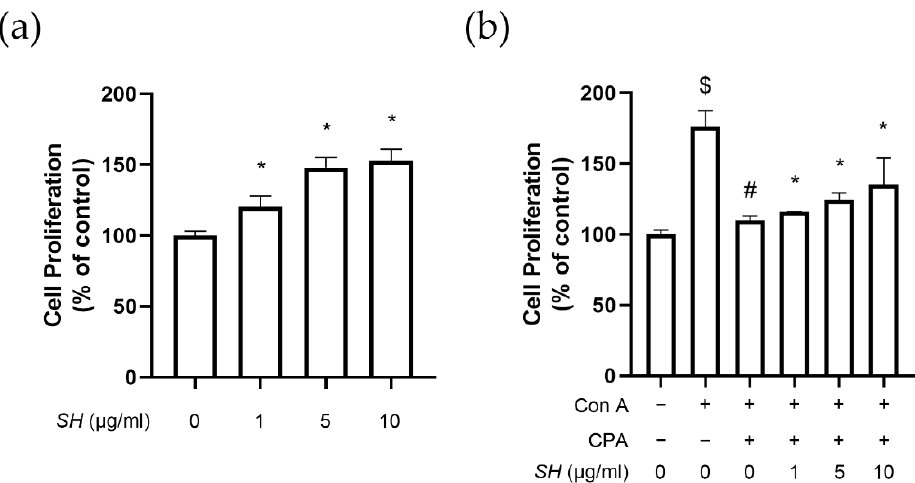
Figure 7. Effects of SH on splenocyte proliferation. Splenocytes were isolated from spleen tissues of naïve mice. ( a ) The cell proliferation of splenocytes measured after 24 h treatment with SH. * p < 0.05 vs. untreated cells. ( b ) Immunosuppression in splenocytes was induced with CPA treatment for 24 h. Then, cell proliferation of splenocytes was measured after 48 h treatment with Con A with or without SH. $ p < 0.05 vs. untreated cells, # p < 0.05 vs. Con A-treated cells, * p < 0.05 vs. Con A/CPA- treated cells. Results are displayed as mean ± SD of three or more separate experiments.